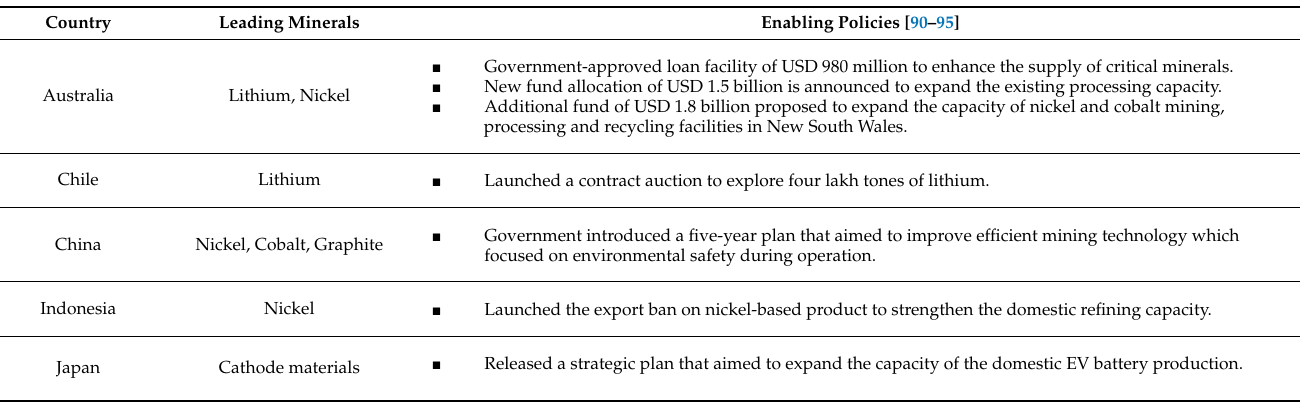
Table 1. Leading countries and their policies that enable a sustainable battery supply